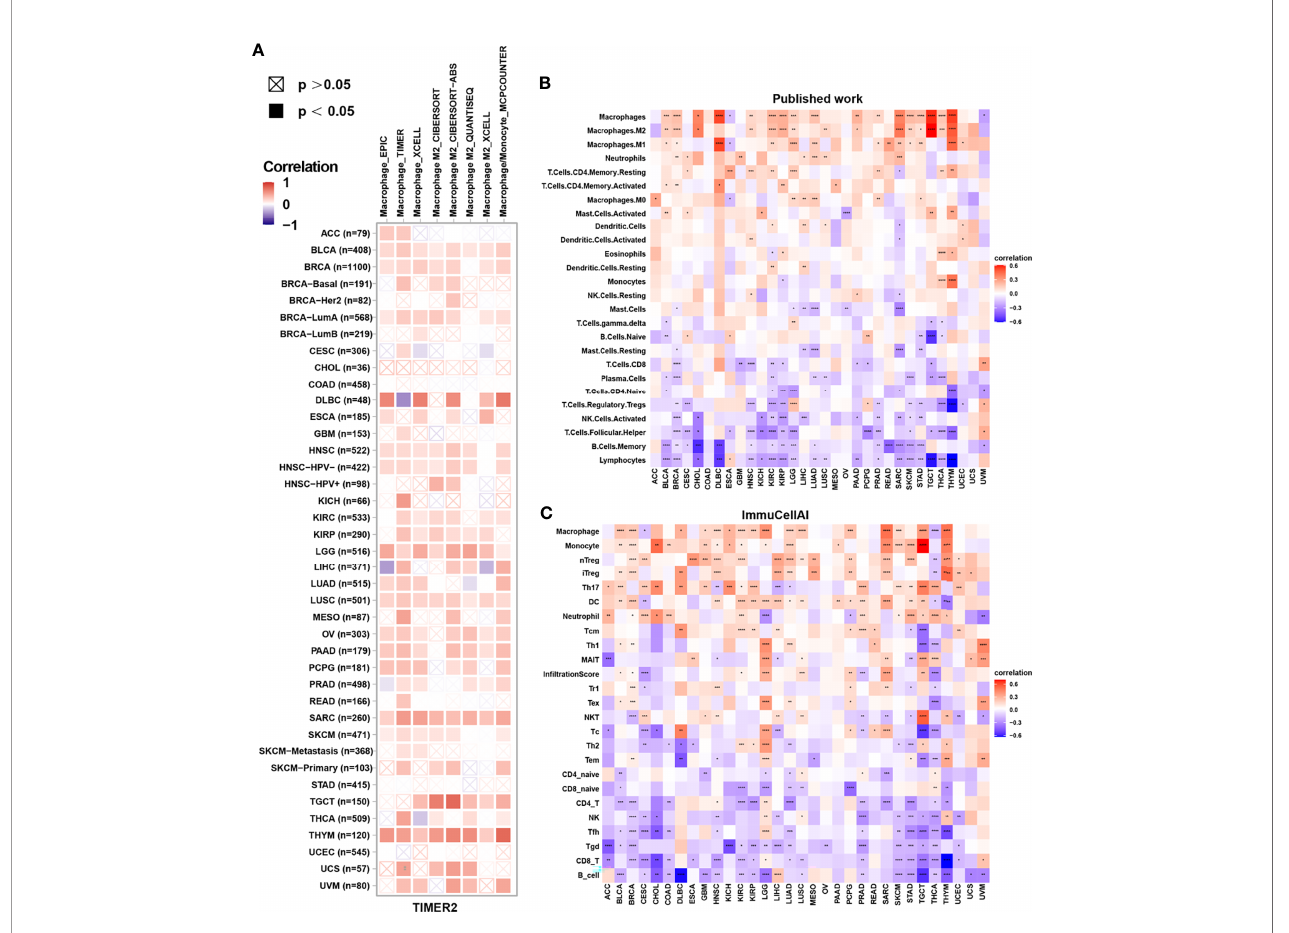
FIGURE 7 | CorrelationbetweenFUCA2expressionandlevelsoftumor in fi ltrationacrossdifferentimmunecells. (A) CorrelationbetweenFUCA2expressionandmacrophages fromTIMER2database. (B) CorrelationbetweenFUCA2 anddifferentimmunecellsfrom publishedstudy. (C) CorrelationbetweenFUCA2 expressionanddifferentimmunecells fromImmuCellAI database. Redrepresentspositivecorrelation,bluerepresentsnegativecorrelation, andthedarker thecolor,thestronger thecorrelation. *P<0.05, **P<0.01, ***P <0.001,